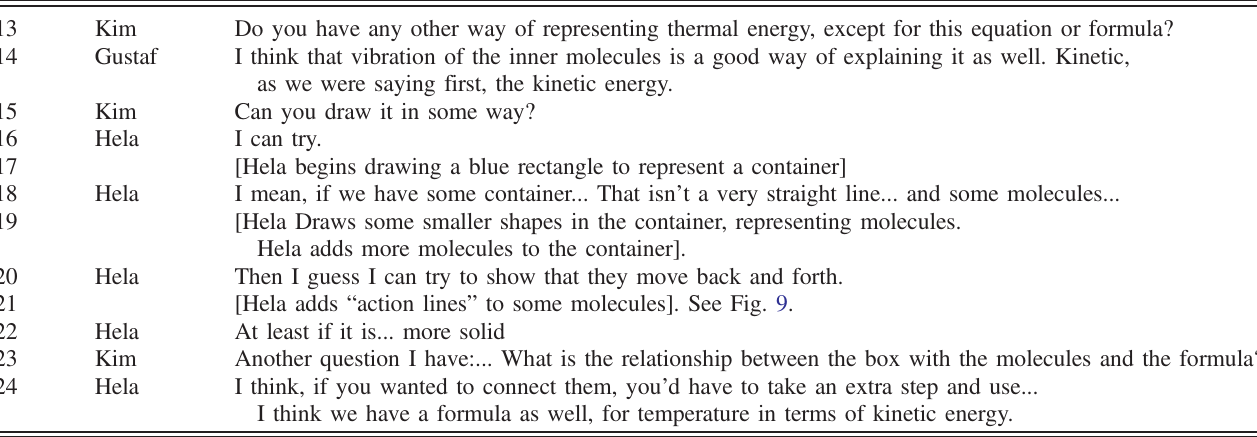
TABLE V. Transcript of a conversion between verbal register and a sketch. Continuation of Table II.